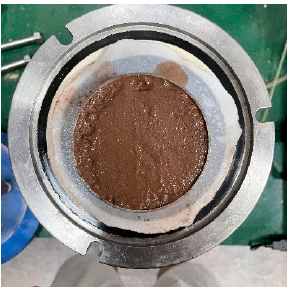
Figure 7. TRIM System ( a ) Equipment, ( b )control panels, and ( c ) pressure chambers. The saturated soil samples were put into a pressure chamber (Figure 8) for exhaus- tion, and dehumidification and hygroscopy were carried out after the exhaustion. Table 3 shows the process of dehumidification and hygroscopy.